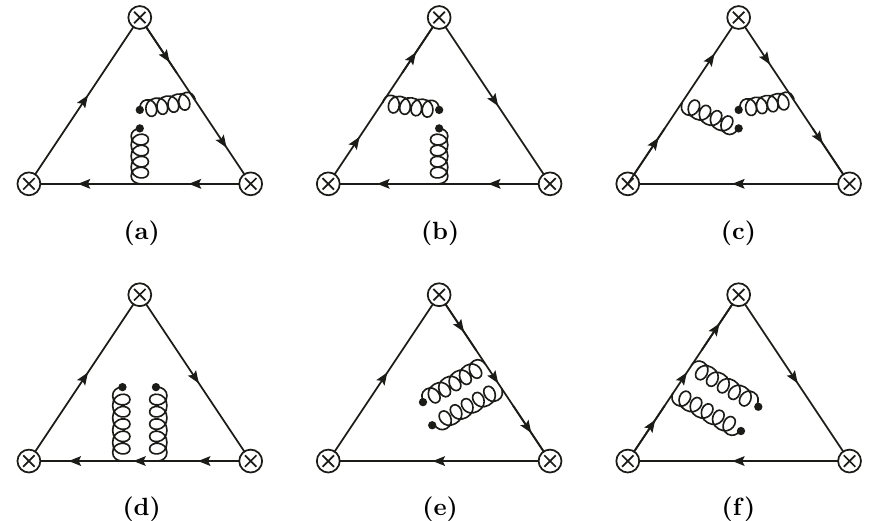
Figure 5. An illustration of the quark propagator in the external gluon (cid:12)eld (6.1). On the right-hand side, the (cid:12)gures stand for (6.2a), (6.2b) and (6.2c), respectively.